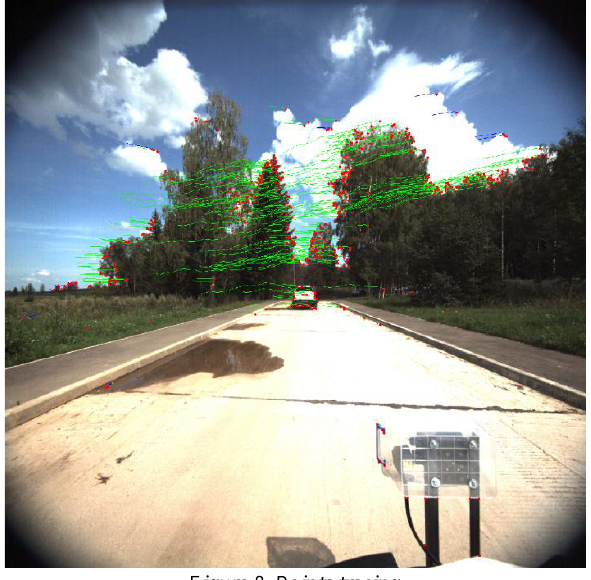
Figure 8. Points tracing